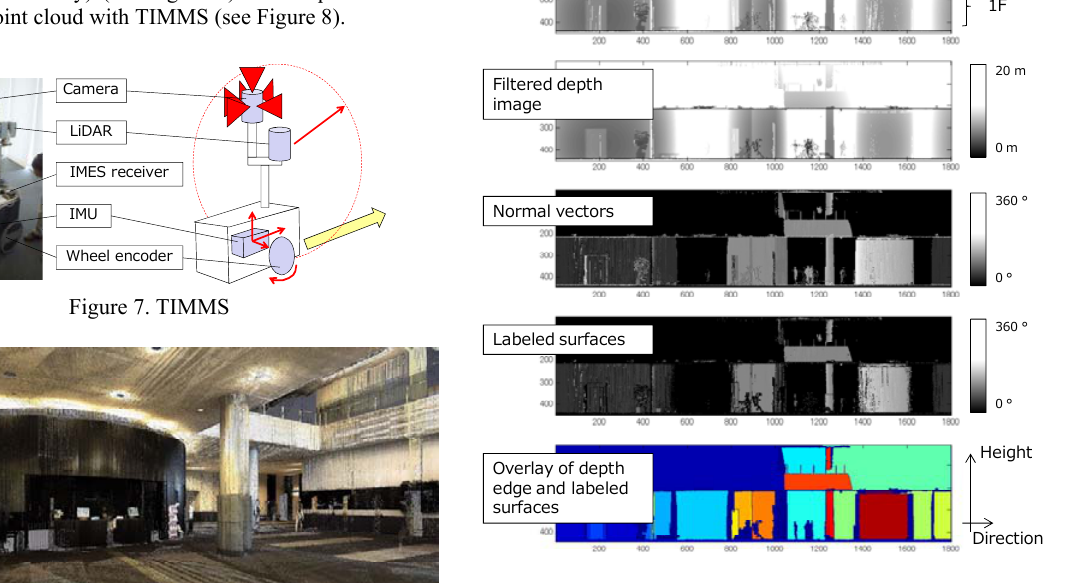
Figure 10. Results after point-based rendering and point clustering Each vertical axis shows height direction and each horizontal axis shows direction. Intensity values in the depth image and filtered depth image indicate the depth from the viewpoint. Moreover, intensity values in the normal vectors and labeled surfaces indicate the horizontal direction of the point cloud. In addition, color values in the initial surfaces indicate labels of surfaces. In this experiment, spatial resolution was set as 0.2° in the horizontal direction and 2 cm in the height direction. space. The left image shows the input point cloud and the right image shows a result after polygon extraction.